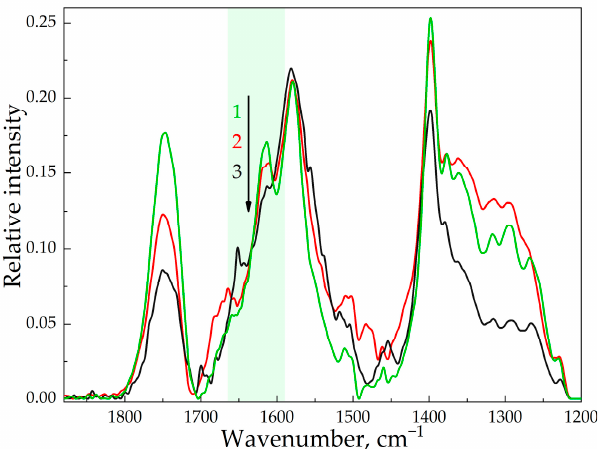
Figure 8. The normalized FTIR spectra of “fresh” MP solution (1) and MP solution stored for 1 day (2) and 6 days (3), C MP = 0.01 M, 22 ° С .